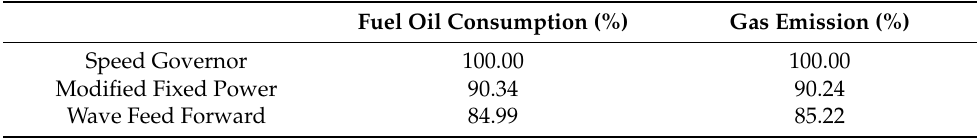
Table 8. Pacific case—accumulated FOC and gas emission